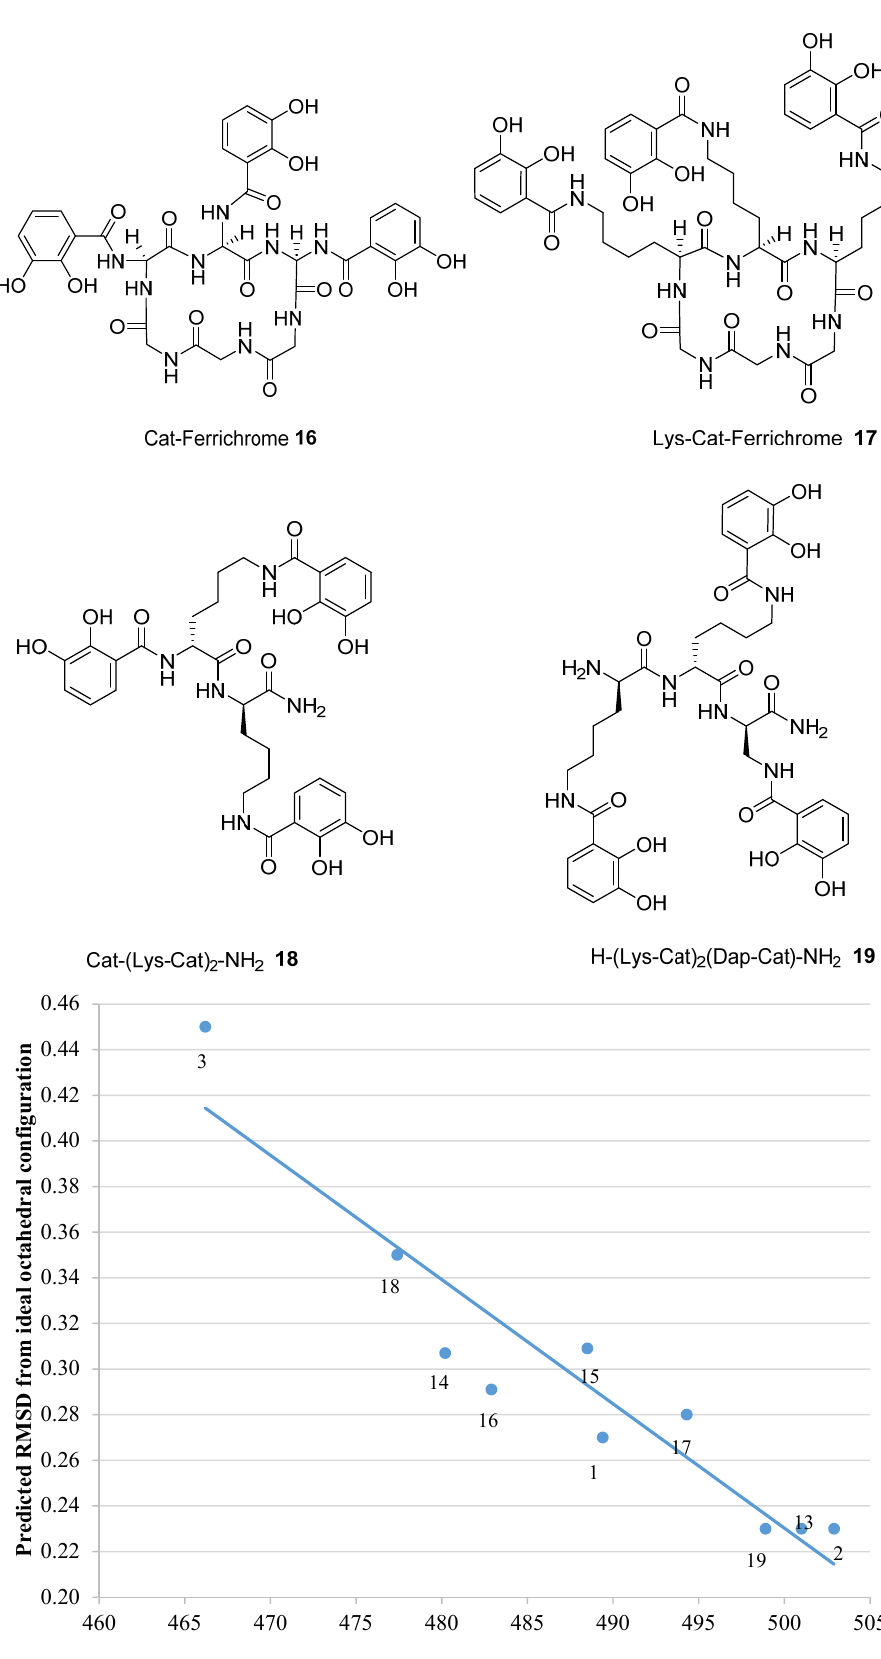
Figure 4. The relationship between predicted RMSD values and sum of transverse Fe-coordination angles for a series of peptide based tricatecholate ligands.